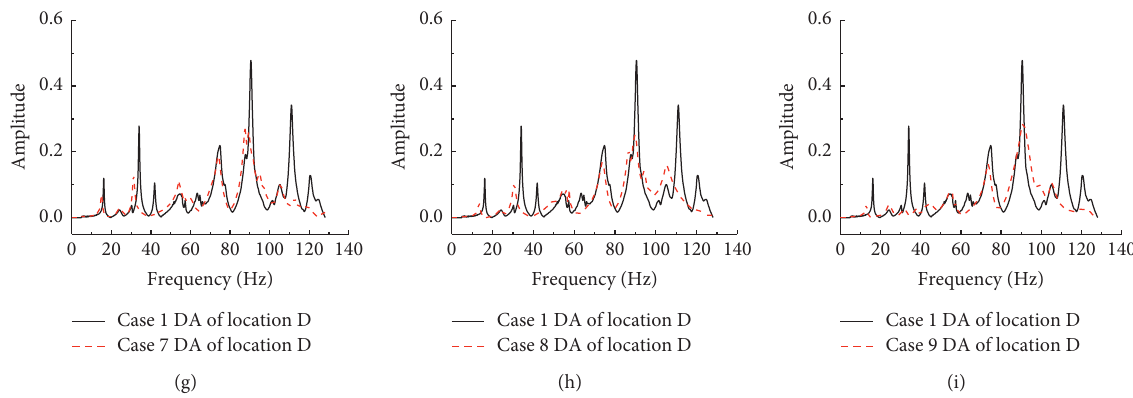
Figure 11: Comparison of DA of driving point D under different cases, (a) 1 vs.1; (b) 1 vs. 2; (c) 1 vs. 3; (d) 1 vs. 4; (e) 1 vs. 5; (f) 1 vs. 6; (g) 1 vs. 7; (h) 1 vs. 8; (i) 1 vs. 9.